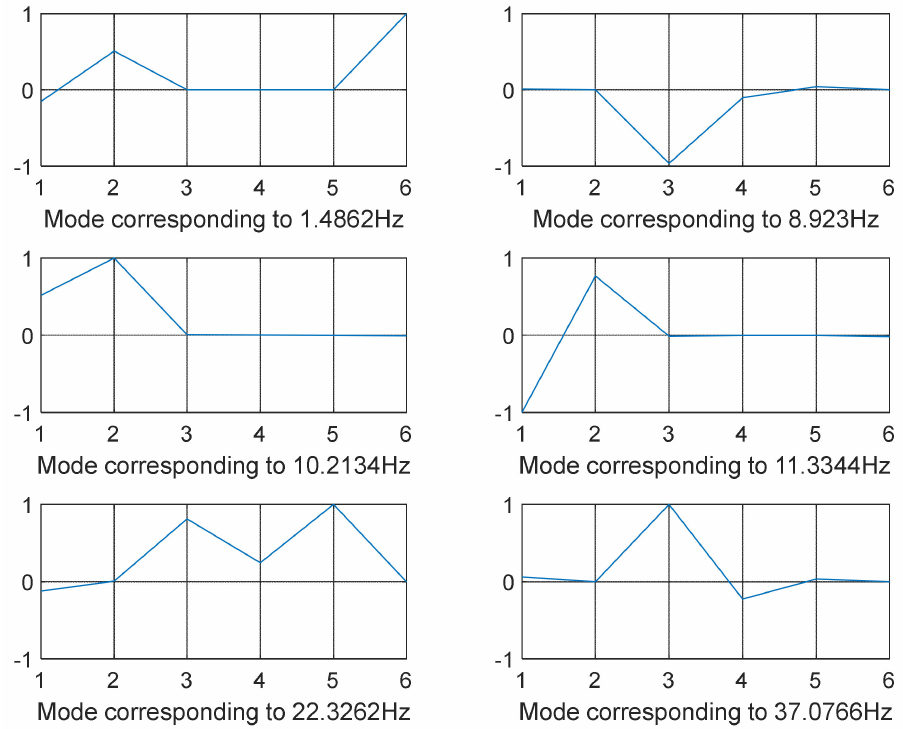
Figure 13. SQP-optimized mode shapes 1–6 (12-DOF model—combined